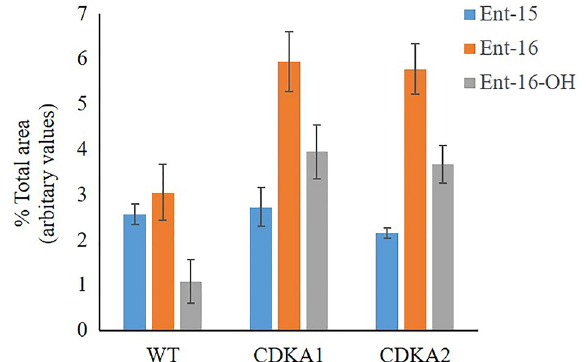
Figure 3. GC/MS analysis of cell ent -kaurene and ent -kaurenoic acid levels. The graph represents the area of ent -kaur-15ene, ent -kaur-16-ene and 16-hydroxy- ent -kaurene peaks to the total peaks of the chromatogram (n = 3).